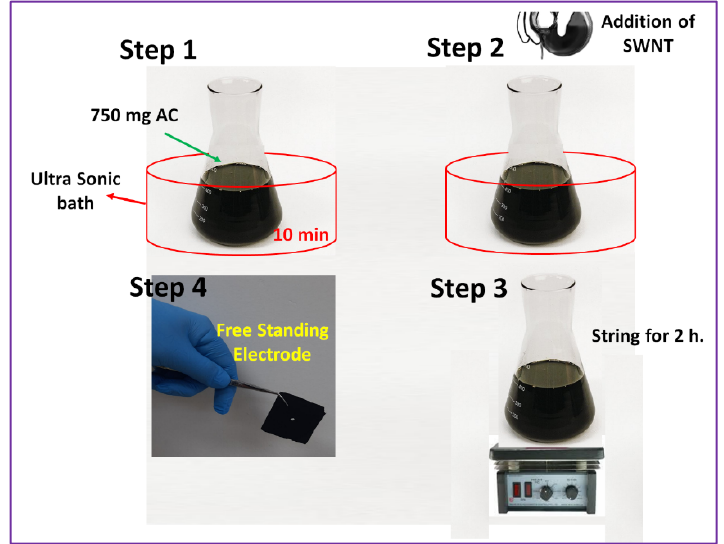
Figure 1. Schematic illustration for the synthesis of freestanding electrode.